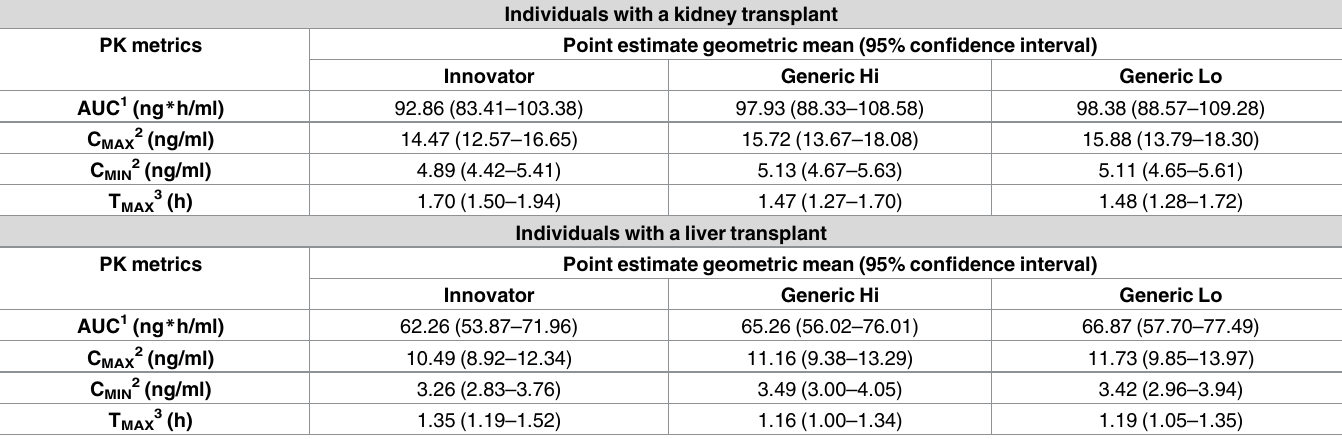
Table 3. Comparison of key pharmacokinetic parameters after administration of the different tacrolimus